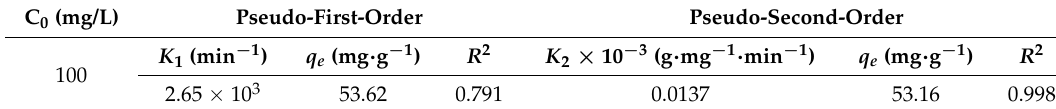
Table 3. Kinetic parameters of the pseudo-first-order and pseudo-second-order models for Cr(VI) adsorption onto SS/KL beads.